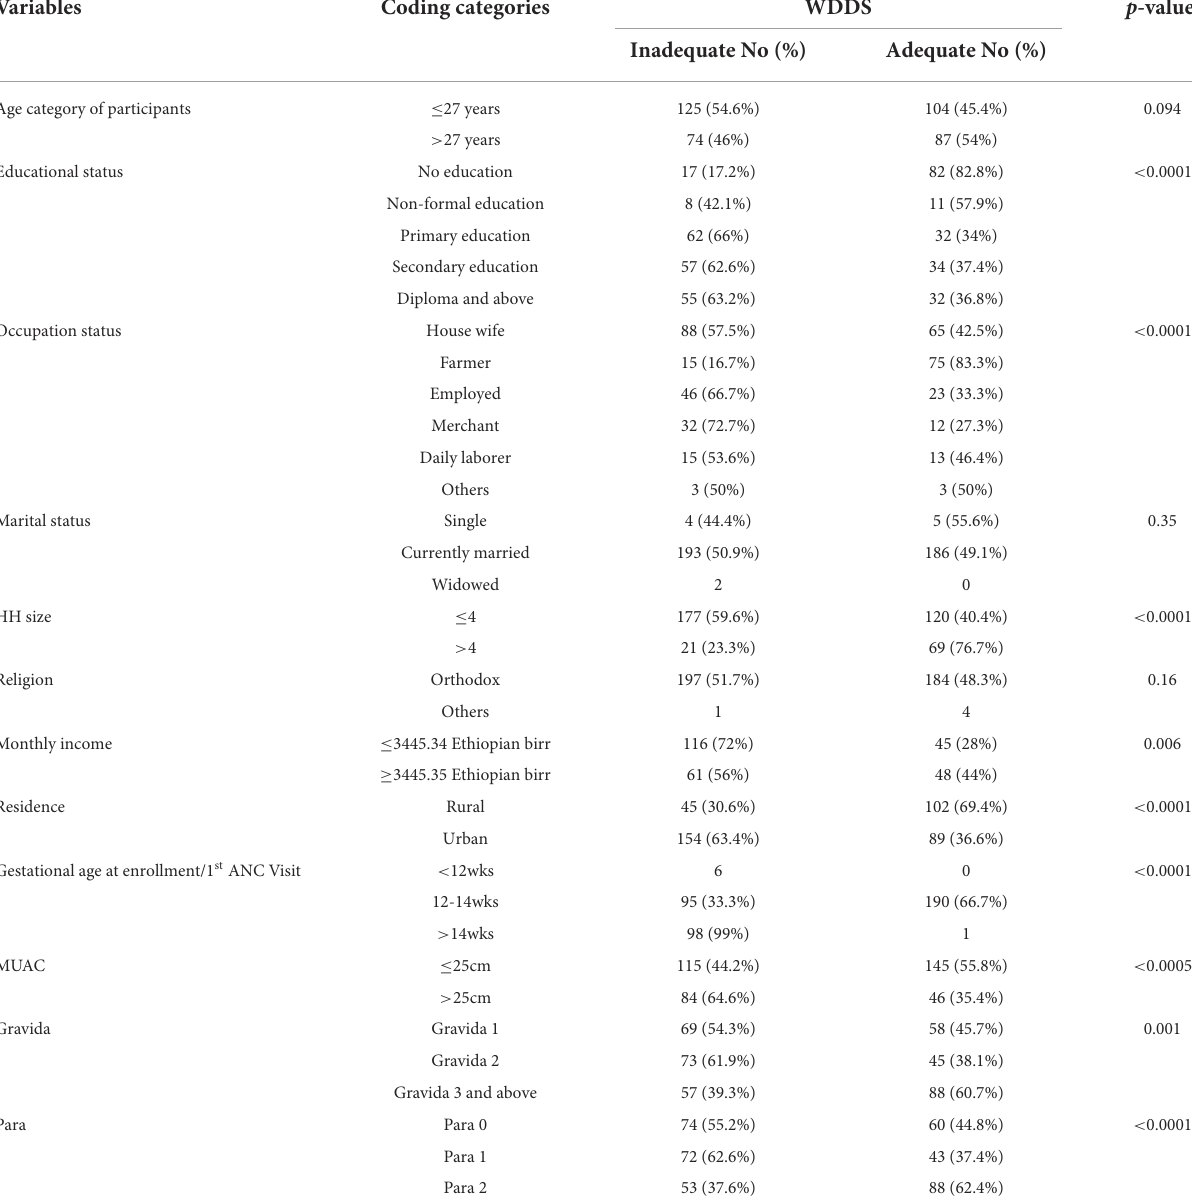
TABLE 1 Baseline demographic, socio-economic, and anthropometric characteristics of the study participants in the east Gojjam zone, northwest Ethiopia,